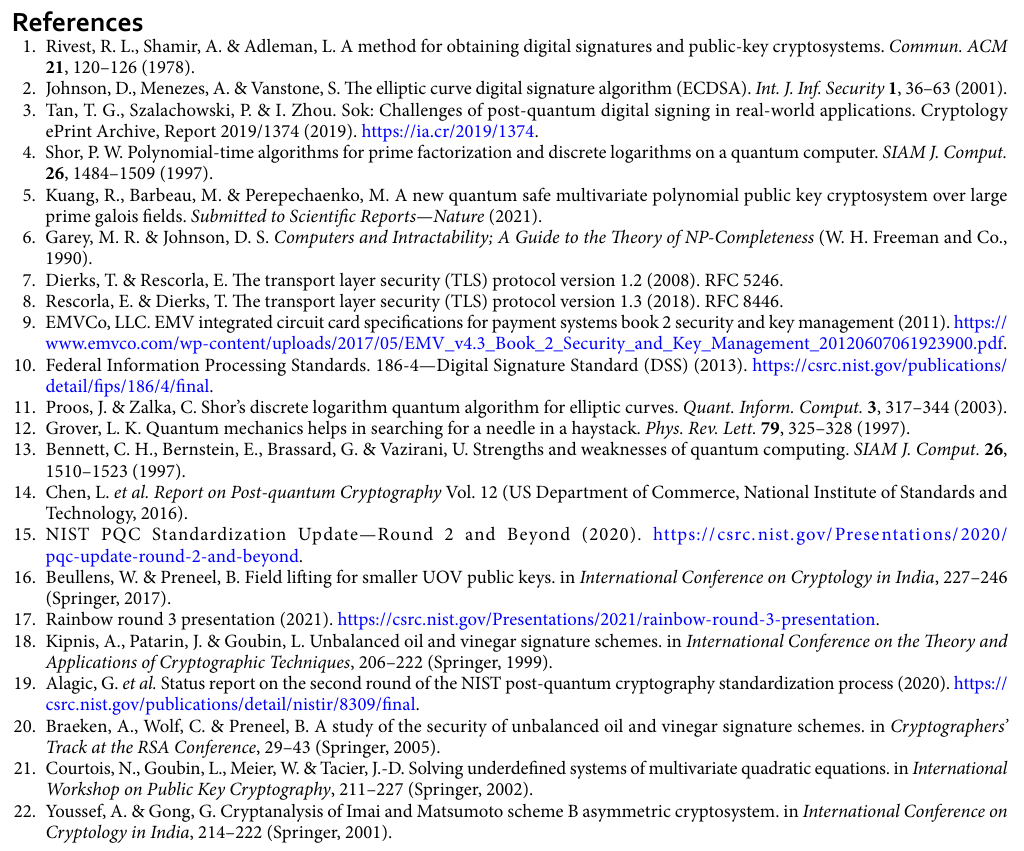
Table 6 values show that MPPK/DS achieve more efficient key generation and signature creation procedures compared to the Rainbow and GeMSS signature schemes. However, the signature verification performance of MPPK/DS is not as efficient as the Rainbow algorithm for level I security. For level III, MPPK/DS performance is comparable with Rainbow and GeMSS. For level V, a noticeable difference between values is observed, with MPPK/DS outperforming both the Rainbow and GeMSS signature schemes. Overall, MPPK/DS achieves rather small public key and signature sizes and offers efficient key